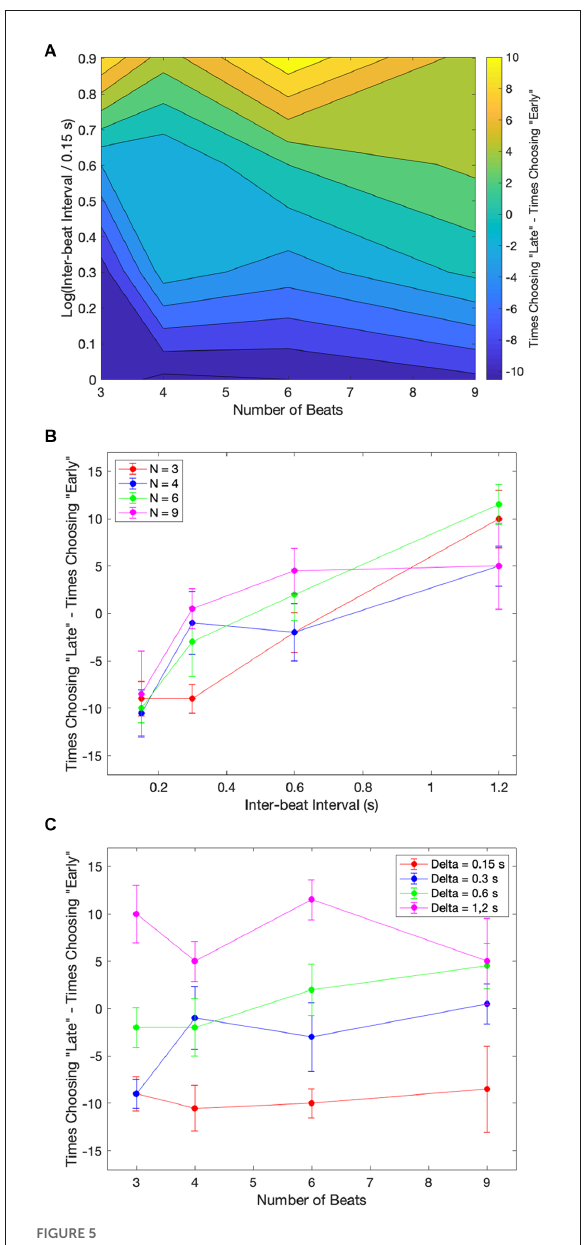
FIGURE5 Examples of the median of the data across subjects for the case where the last beat had no deviation. (A) Contour plot of the excess of “late” responses over “early” ones. (B) Excess of “Late” responses as a function of the inter-beat interval parametric on the number of beats. (C) Excess of “Early” responses as a function of the number of beats parametric on the inter-beat interval. Subjects show a bias towards “Early” responses for low inter-beat intervals and the opposite bias for longer